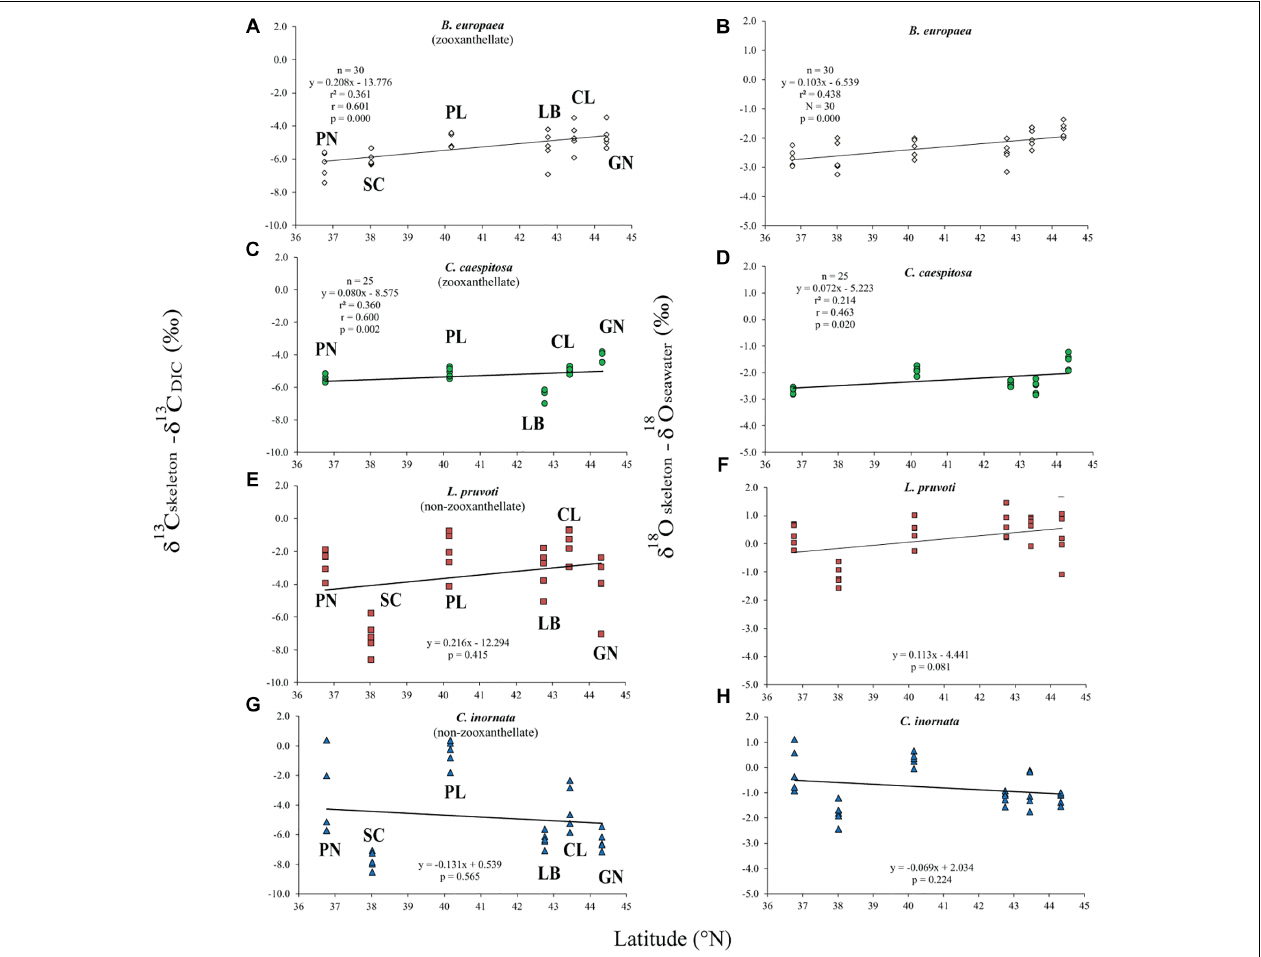
FIGURE 4 | The relation between skeletal δ 13 C and δ 18 O with latitude in B. europaea (A,B) , C. caespitosa (C,D) , L. pruvoti (E,F) , and C. inornata (G,H) . r 2 , Spearman’s determination coefficient; r , Spearman’s correlation coefficient; n , number of